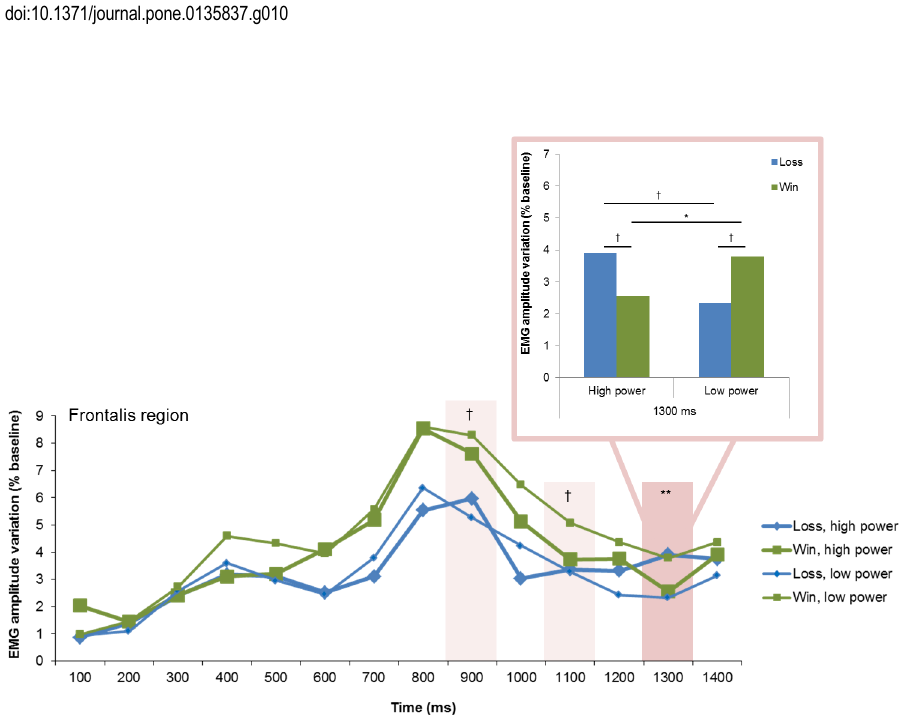
Fig 11. Electromyographic (EMG) amplitude variations over the frontalis region, illustrating the interaction of goal conduciveness and power across time. † p < .10, * p < .05, ** p <